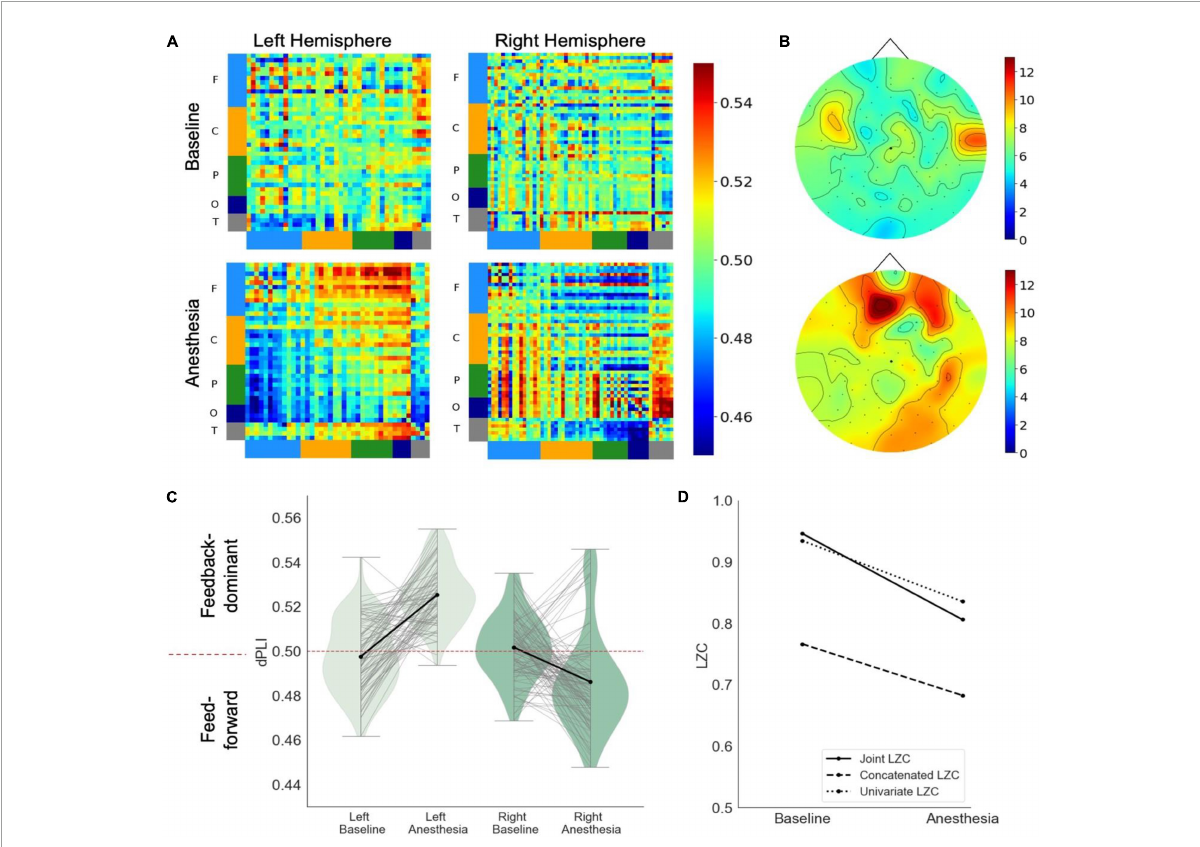
FIGURE3 Case 3 (A) directed functional connectivity (dPLI) within the right and left hemisphere during baseline and anesthesia. Electrodes are ordered per region: F, frontal; C, central; P, parietal; T, temporal; O, occipital (B) network hubs during baseline and anesthesia. (C) Directed functional connectivity (dPLI) between frontal and parietal regions within the left and right hemisphere. Light gray lines represent individual electrodes, black lines represent the mean. (D) Three types of Lempel-Ziv complexity and its propofol-induced